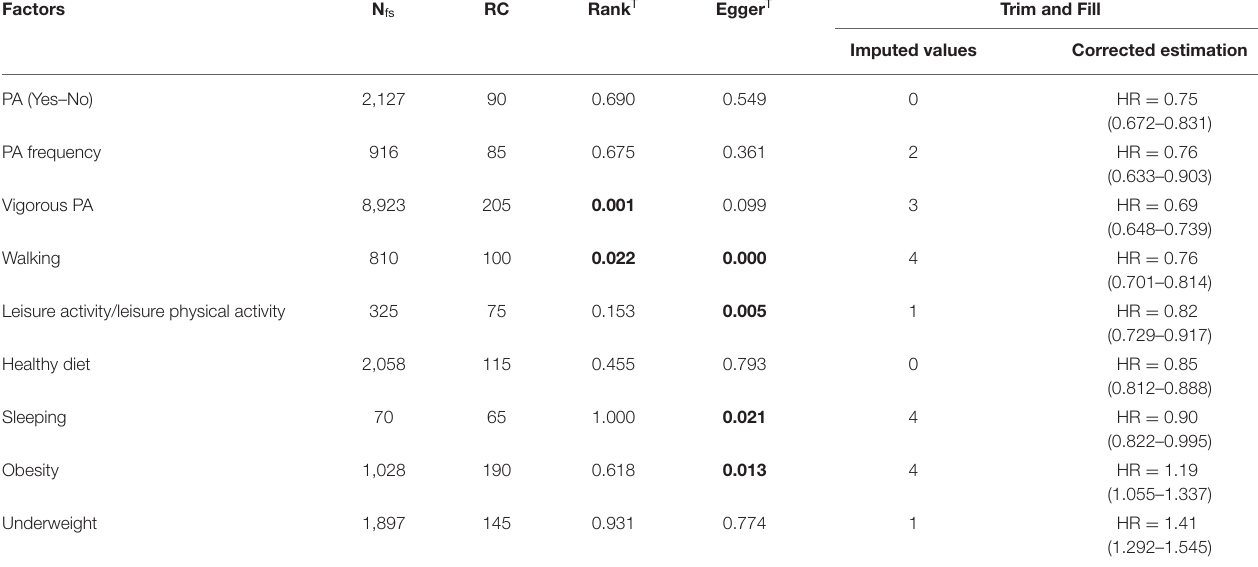
TABLE 2 | Analysis of publication bias associated with significant estimates. Factors N fs RC Rank T Egger T Trim and Fill